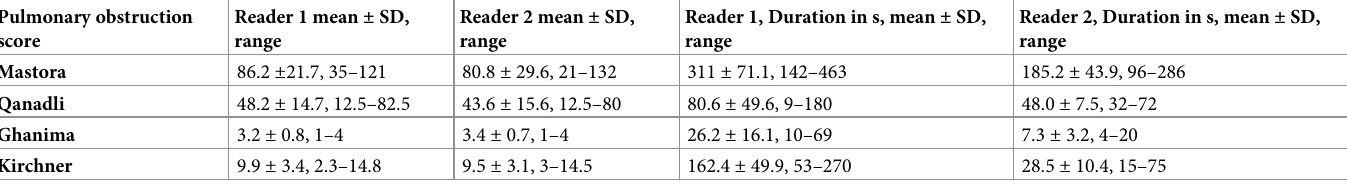
Abbr. SD = standard deviation, s =